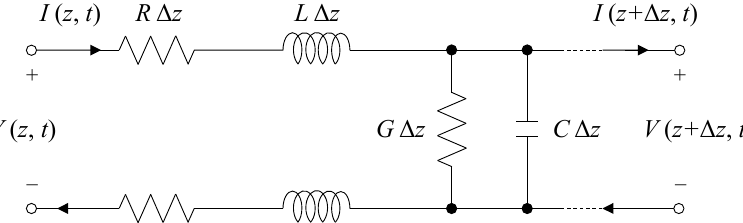
Figure 1. Equivalent circuit model of the differential length Δ z of a transmission line. R , L , G , and C denote resistance ( Ω /m), inductance (H/m), capacitance (F/m), and conductance (S/m), respectively. V ( z , t ), V ( z + d z , t ), I ( z , t ), and I ( z + d z , t ) denote the instantaneous voltages and currents at the input ( z ) and output ( z + d z ), respectively.